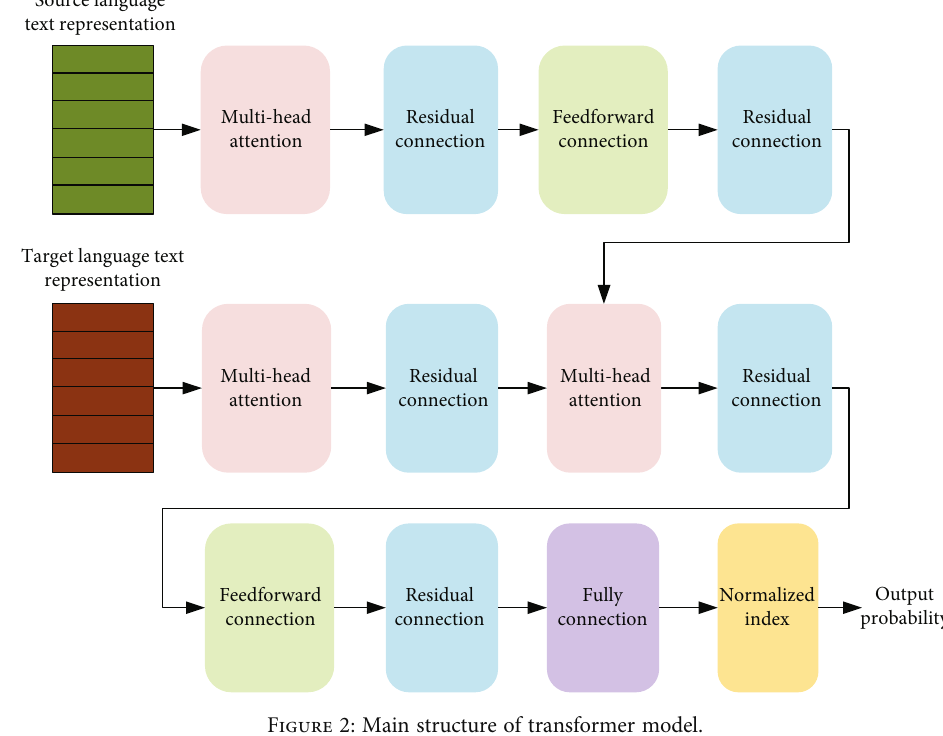
Figure 2: Main structure of transformer model.